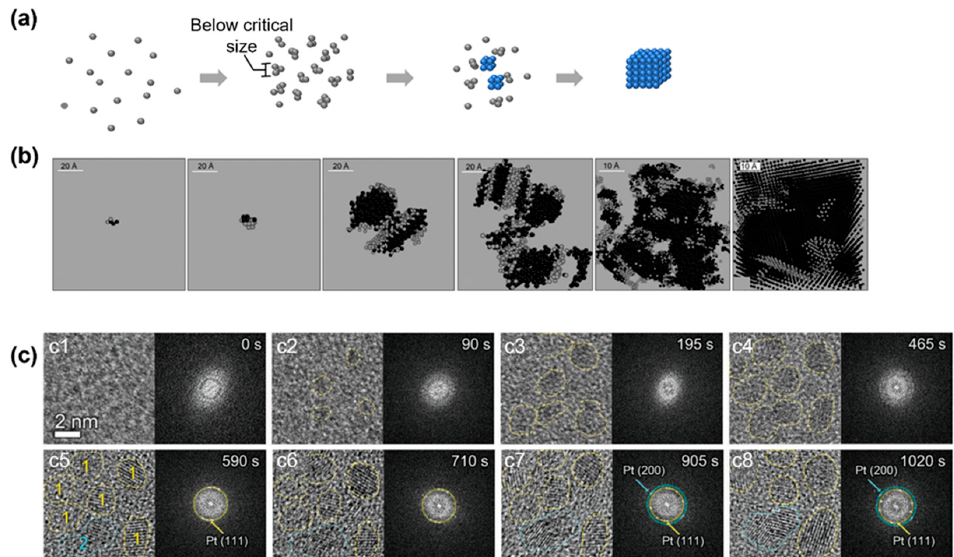
Figure 3. Simulation and experimental observations of the nonclassical crystallization pathway with the formation of an amorphous cluster below the critical nucleus size: ( a ) Schematics illustrating the nonclassical crystallization pathway and highlighting the amorphous structure below the critical size. ( b ) Simulation snapshots of clusters of silver atoms at different crystallization conditions to illustrate the amorphous structure below the critical nucleus size. From left to right, the systems were cooled down with cooling rates of 6 × 10 13 , 5 × 10 13 , 10 13 , 5 × 10 12 , 2 × 10 12 , and 10 12 K/s, respectively. Reproduced with permission from Ref. [64]. Copyright 2010 Science China Press and Springer-Verlag Berlin Heidelberg. ( c ) Liquid-phase TEM observations of the nucleation and growth of platinum nanocrystals that highlight the amorphous structure below the critical size. From c1 to c8 , the temporal evolution of the nuclei is captured by liquid-phase TEM and corresponding fast Fourier transform of each image is shown on the right. Reproduced with permission from Ref. [65] . Copyright 2022 Wiley Materials.